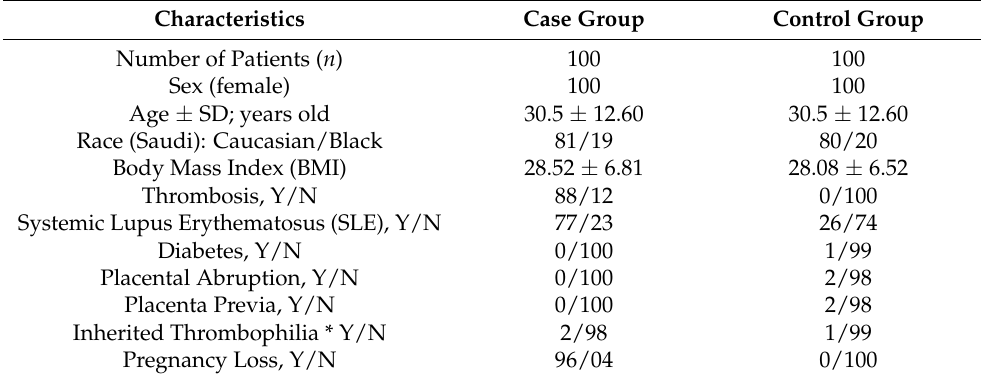
Table 1. Demographic and clinical data of study